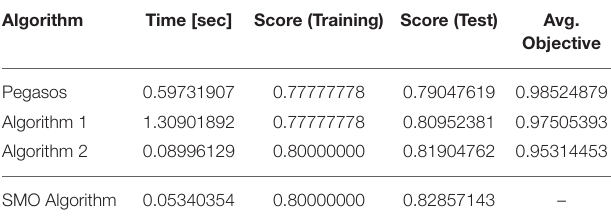
Algorithm 2 performed better than Pegasos and Algorithm 1 in terms of computational time and value of the objective